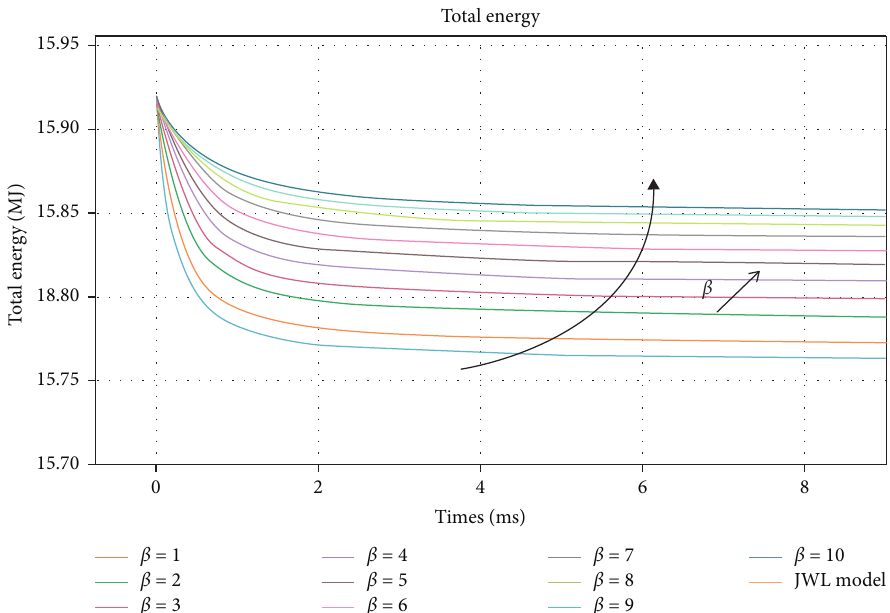
Figure 15: Total energy variation as a function of the time. Cartesian